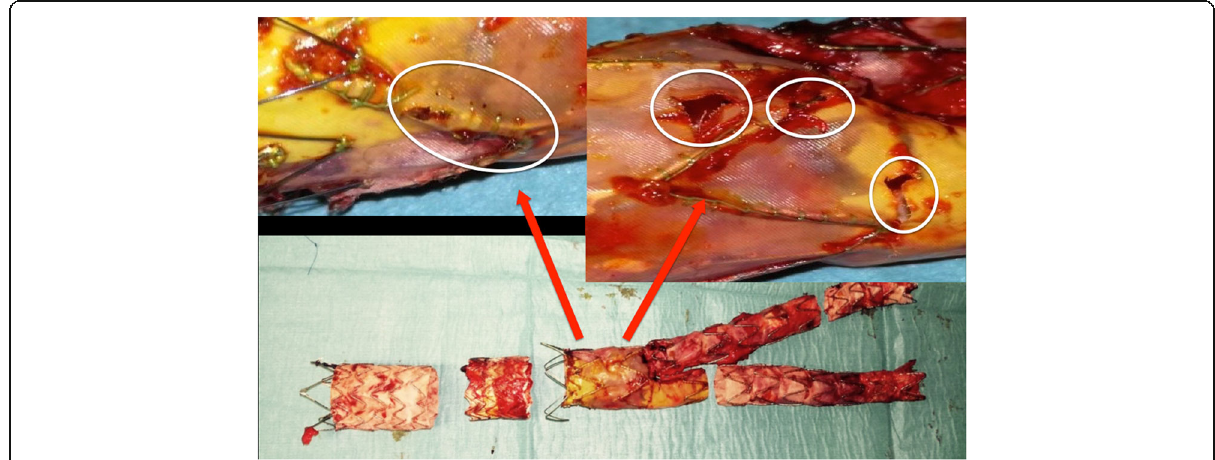
Fig. 3 Endograft removed: tears on endograft fabric on the proximal portion of main body, the running suture of the first support stent was also